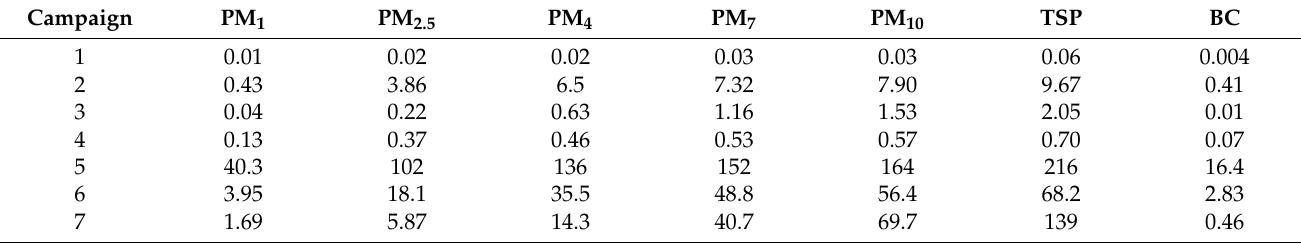
Table 3. Estimated inhaled doses for sampling campaigns ( µ